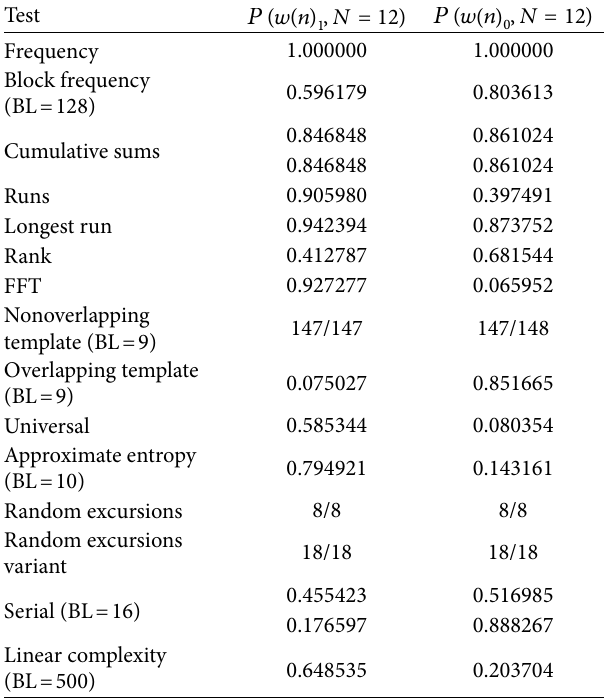
Table 3: National Institute of Standards and Technology (NIST) test